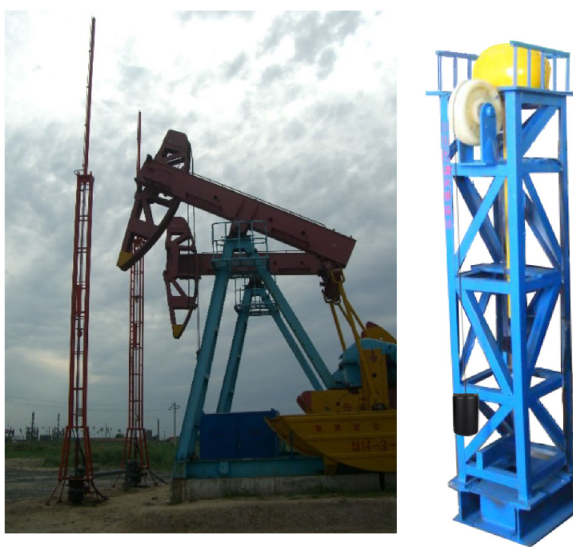
Fig. 3 Single cylinder upright pumping unit and laboratory model prototype